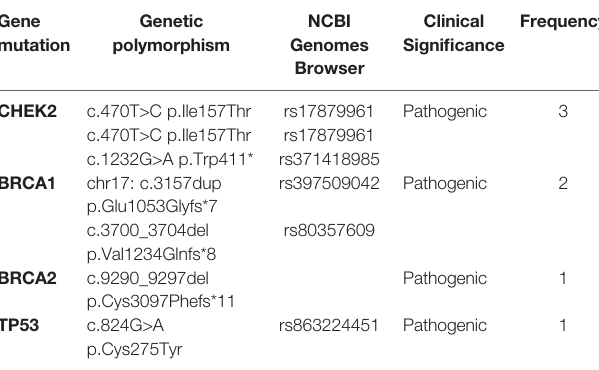
TABLE 3 | Germline pathogenic mutations of young patients with breast cancer as determined by NGS